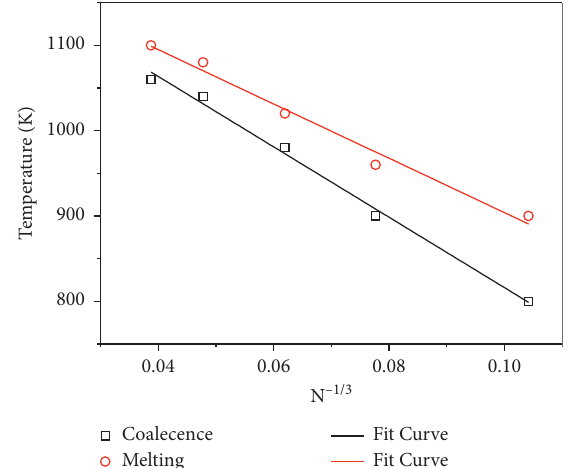
Figure 6: Size effect of coalescence and melting temperatures.